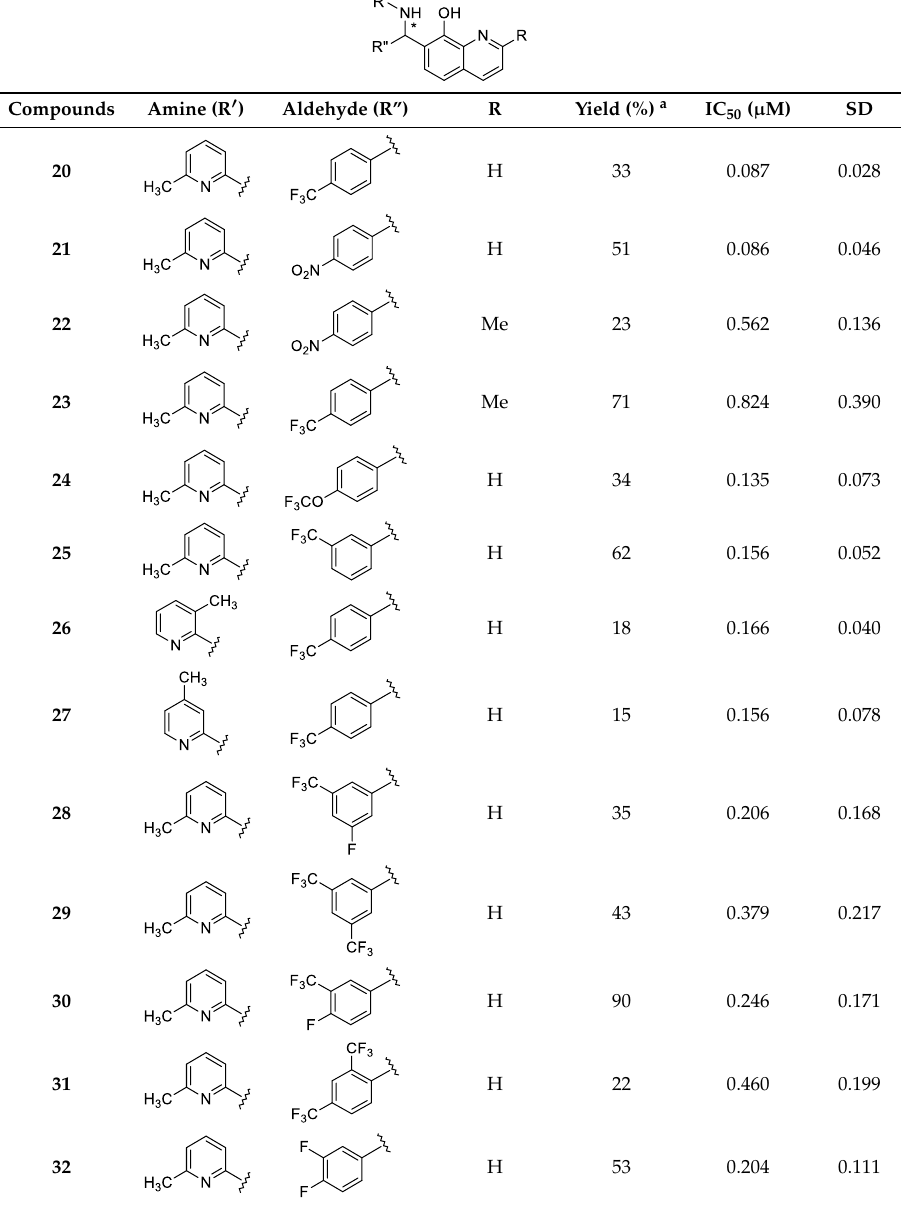
Table 2. Functionalization with several picolines (Subclass 2).